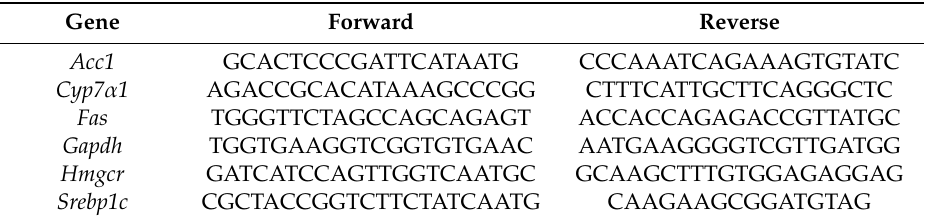
Table 2. Sequences of Primers for Real-time